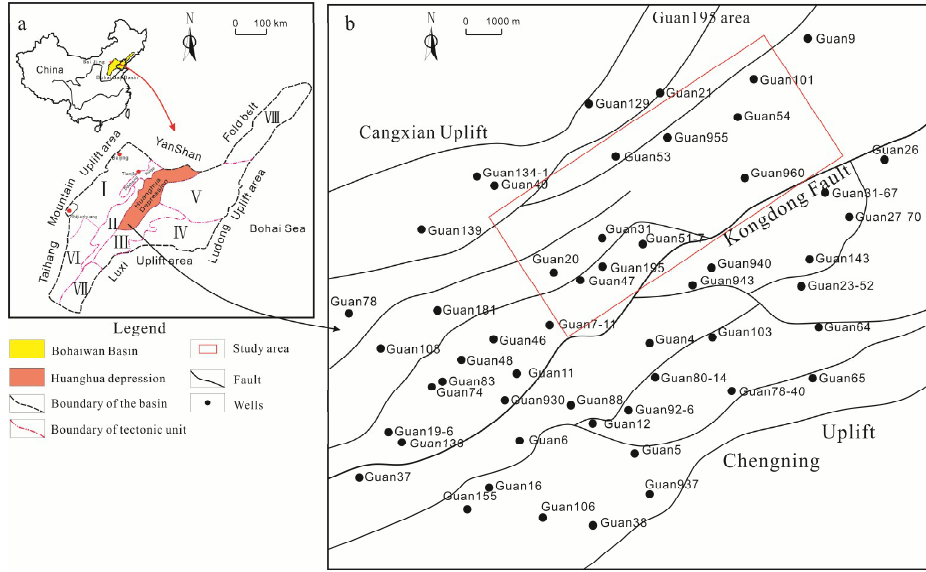
Figure 1. ( a ) Location map of the study area and sub-tectonic units of the Bohaiwan Basin. (I) JiZhong depression zone, (II) CangXian uplift zone, (III) ChengNing uplift zone, (IV) JiYang depression zone, (V) BoZhong depression zone, (VI) XingHeng uplift zone, (VII) LinQing depression zone, (VIII) LiaoHe uplift zone; ( b ) The sub-tectonic units of the study area and well locations.